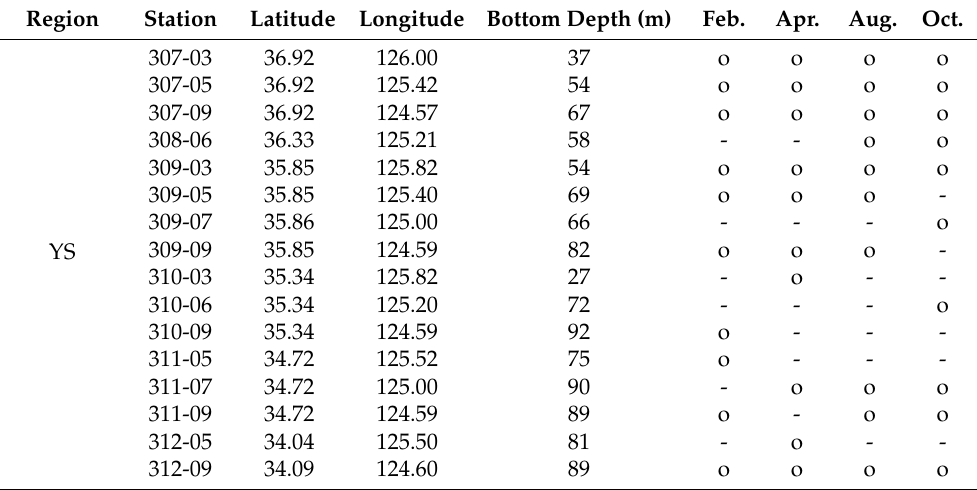
Table 1. Description of sampling sites in the YS, the SS, and the EJS for each cruise period, in 2018. (o) means investigation was conducted, while (-) means investigation was not conducted.